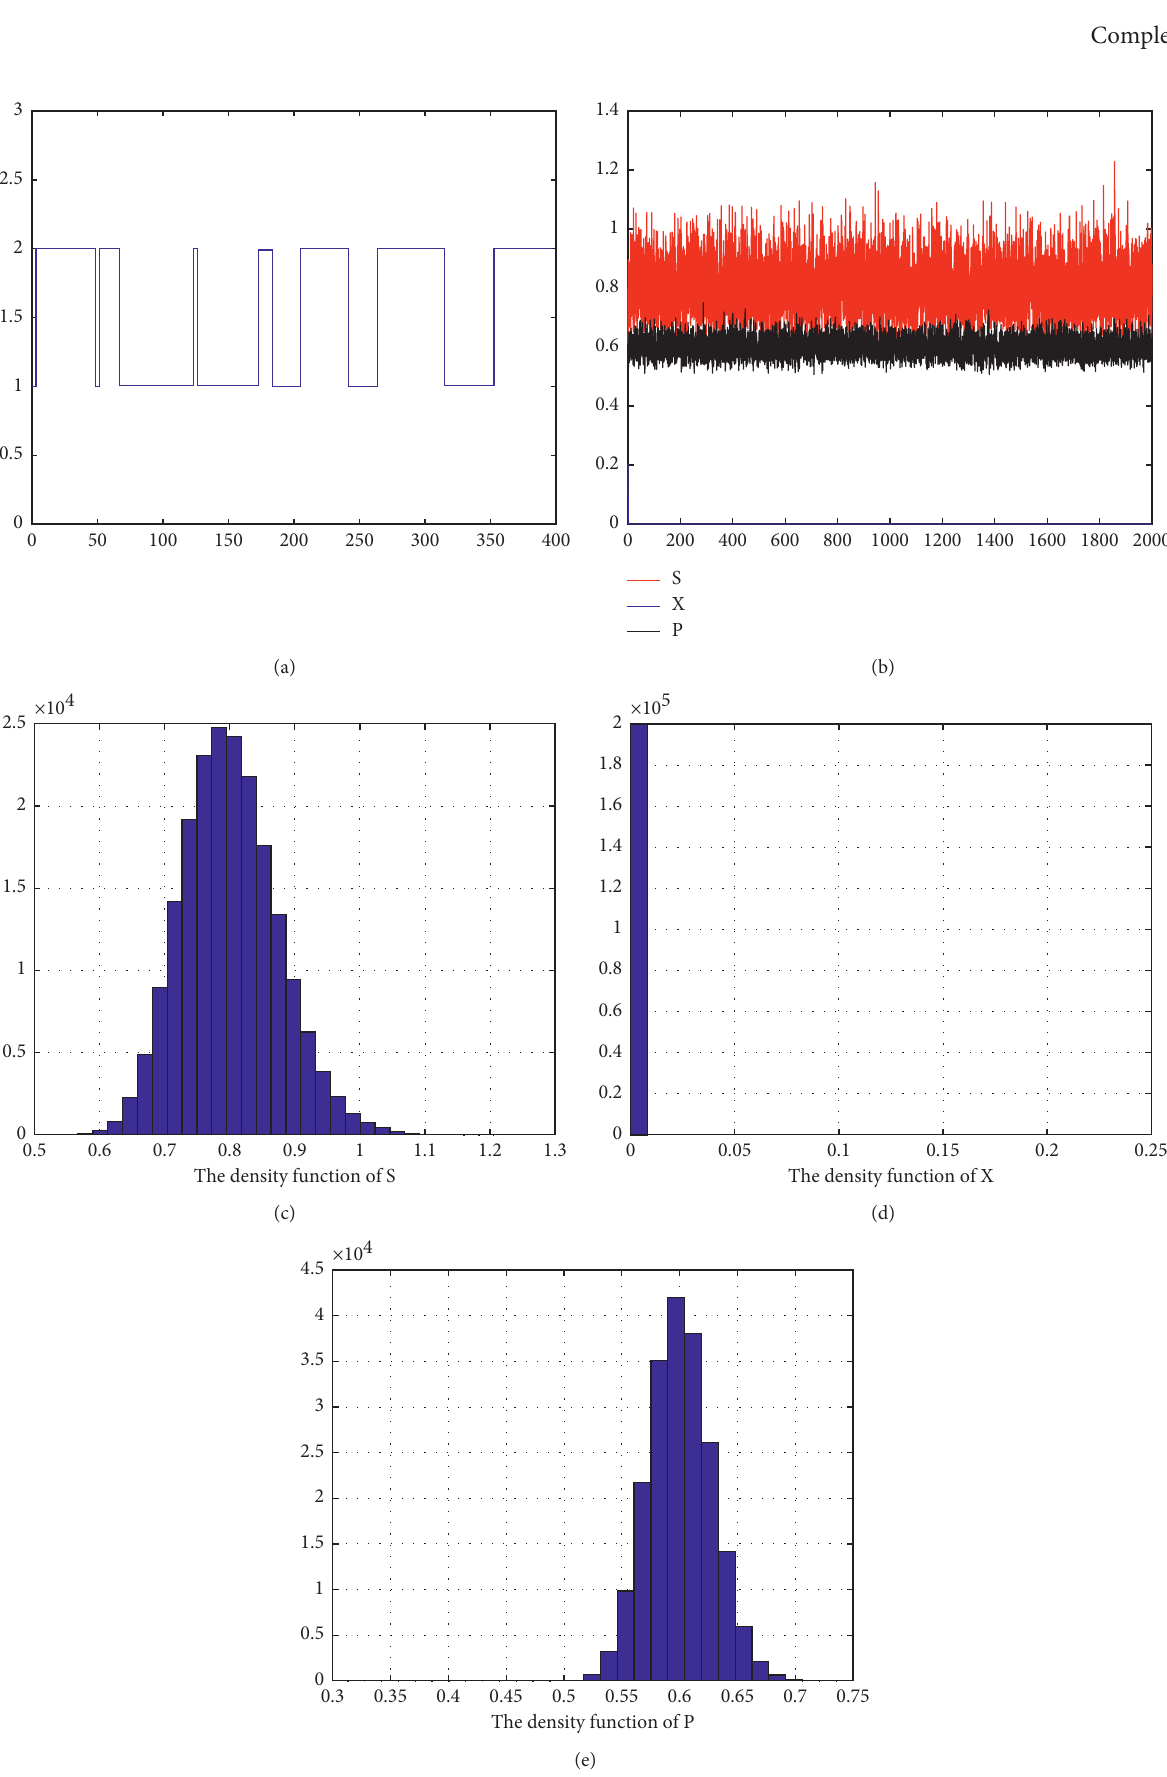
Figure 3: The numerical simulation of solutions of system (4). (a) Markov chain, (b) the solution of system (4), (c) the density function of S ( t ) in system (4), (d) the density function of X ( t ) in system (4), and (e) the density function of P ( t ) in system